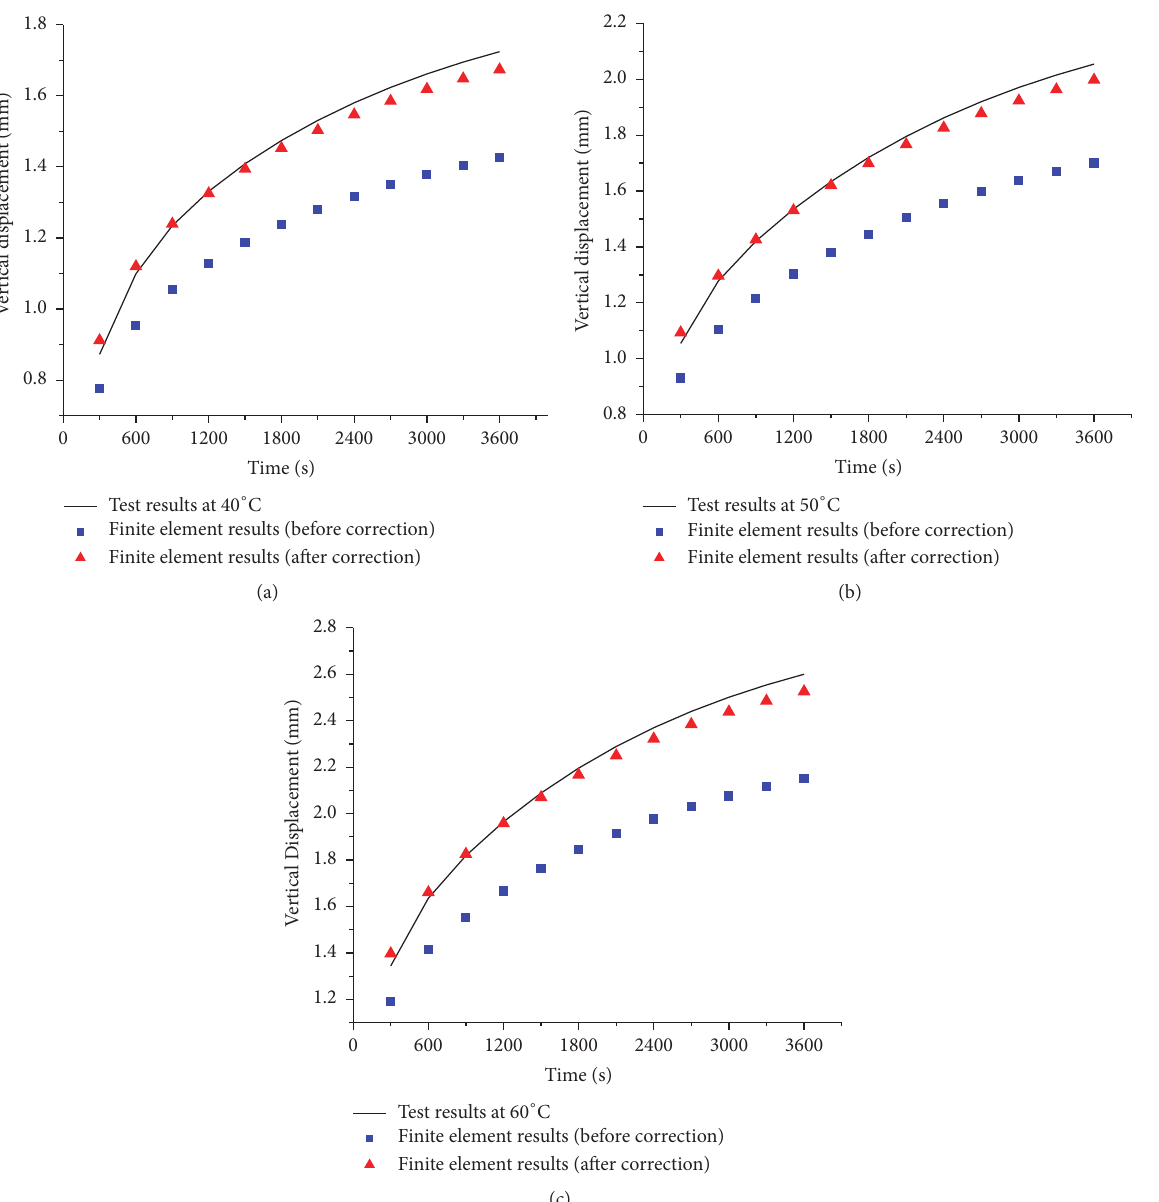
Figure 9: Comparison between the finite element results and the experimental results before and after correction at 40 ∘ C (a), 50 ∘ C (b), or 60 ∘ C (c).